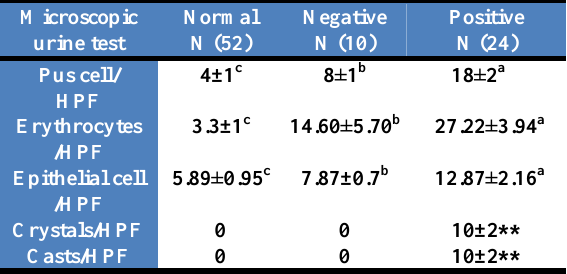
Table, 3: Microscopic examination of urine in control and negative and positive bacterial urine culture samples of slaughtered buffaloes (Mean±SD).